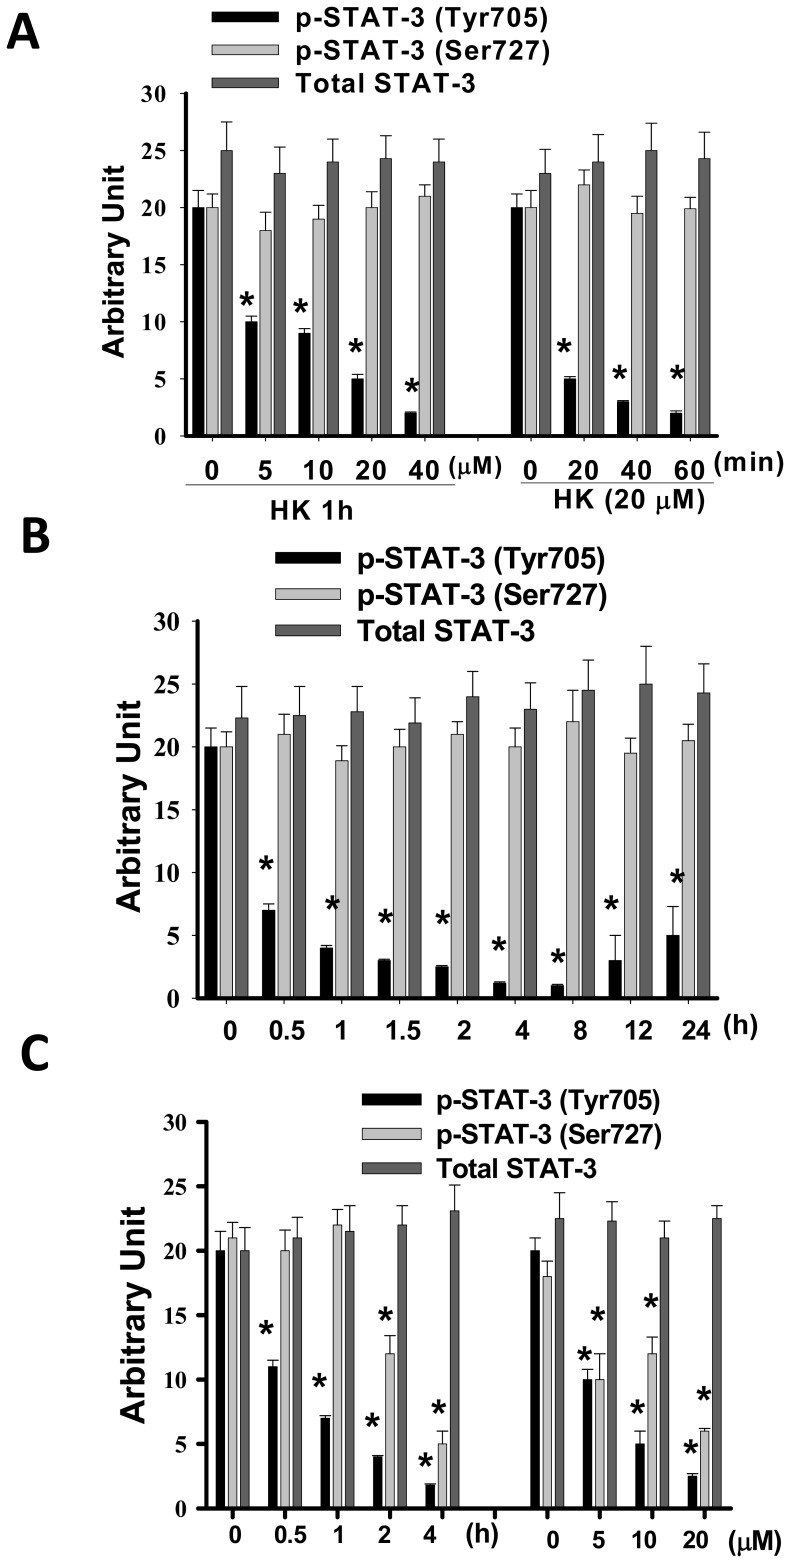
Quantification of honokiol-inhibited STAT-3 phosphorylation in gastric cancer cells and HUVECs.AGS (A) and MKN45 (B) quiescent human gastric cancer cells and HUVECs (C) were treated with and without honokiol (HK, 5–40 µM) for the indicated times. Whole cell lysates were prepared and analyzed by Western blotting for detection of phosphorylated STAT-3 (pSTAT-3, Tyr705). The blottings were reprobed with anti-STAT-3 antibodies for normalization. All data are presented as mean ± SEM of five independent experiments. *p<0.05 as compared with control.